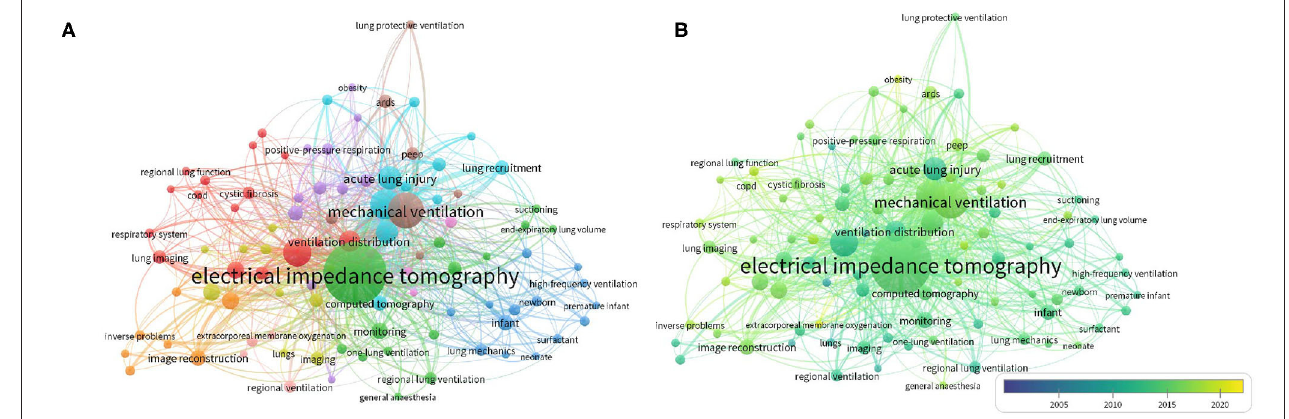
FIGURE 3 | The keyword co-occurrence network and overlay analysis on EIT lung monitoring research from 2001 to May 29, 2021. (A) Network visualization of the keyword co-occurrence. (B) Overlay visualization of keyword co-occurrence. The color indicated various clusters (A) and the average publication year (B) . The circle size indicated the number of occurrences, and the thickness of lines indicated the linkage strength. The color indicated the average publication year of keywords. Circle size indicated the number of occurrences; the thickness of lines indicated the strength of the linkage. The distance between circles indicated their